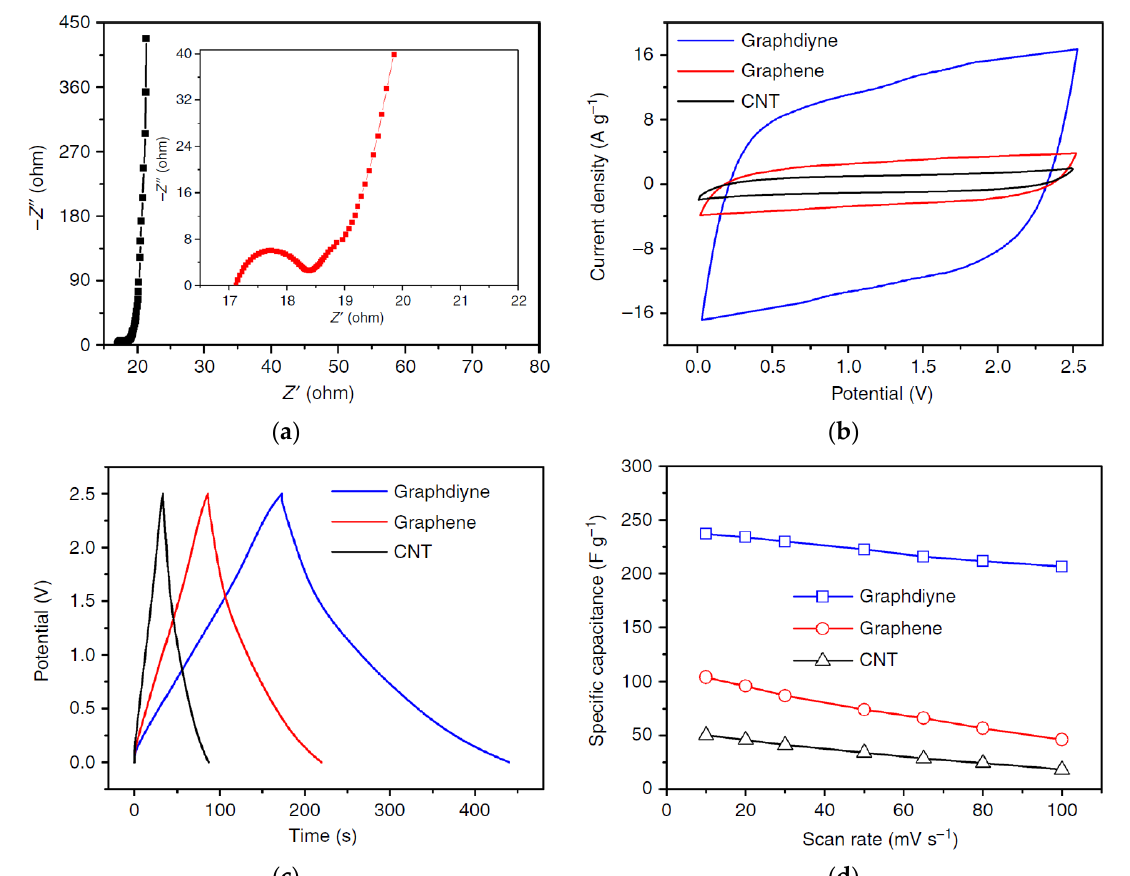
Figure 21. Electrochemical properties of the graphdiyne actuator: ( a ) Nyquist curves (an increased range of 0–22 Ohm is shown on the inset); ( b ) comparative CV curves for electrodes based on CNT, graphene, and graphdiyne forming actuators of the same structure (the scan rate is 100 mV/s); ( c ) charge/discharge curves for actuators with electrodes from CNT, graphene, and graphdiyne; ( d ) specific capacity of the actuators as a function of current density. Reproduced from [49] with permission from Springer Nature. Copyright 2018.